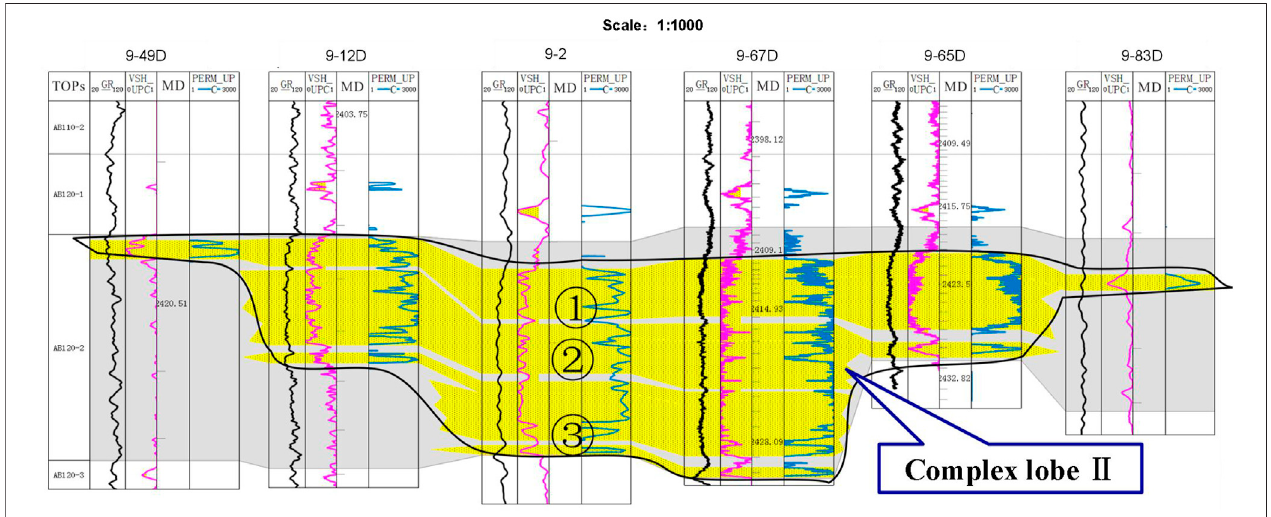
FIGURE 16 | Cross-well section of the AB120 reservoir.